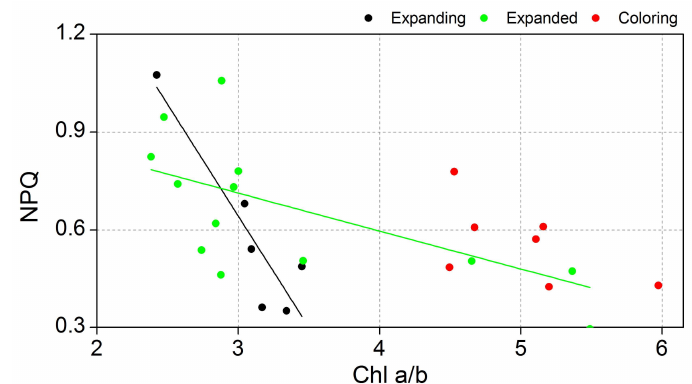
Figure 5. Relationship between Stern–Volmer non-photochemical fluorescence quenching (NPQ) and the ratio of chlorophyll a to chlorophyll b content (i.e., Chl a/b) in each phenophase during the 2014 growing season. Black, green, and red colored circles and lines coincide with values and fitting functions (Table 1) for the leaf expanding, expanded, and coloring phases, respectively. Data from rainy days were excluded from the analysis.